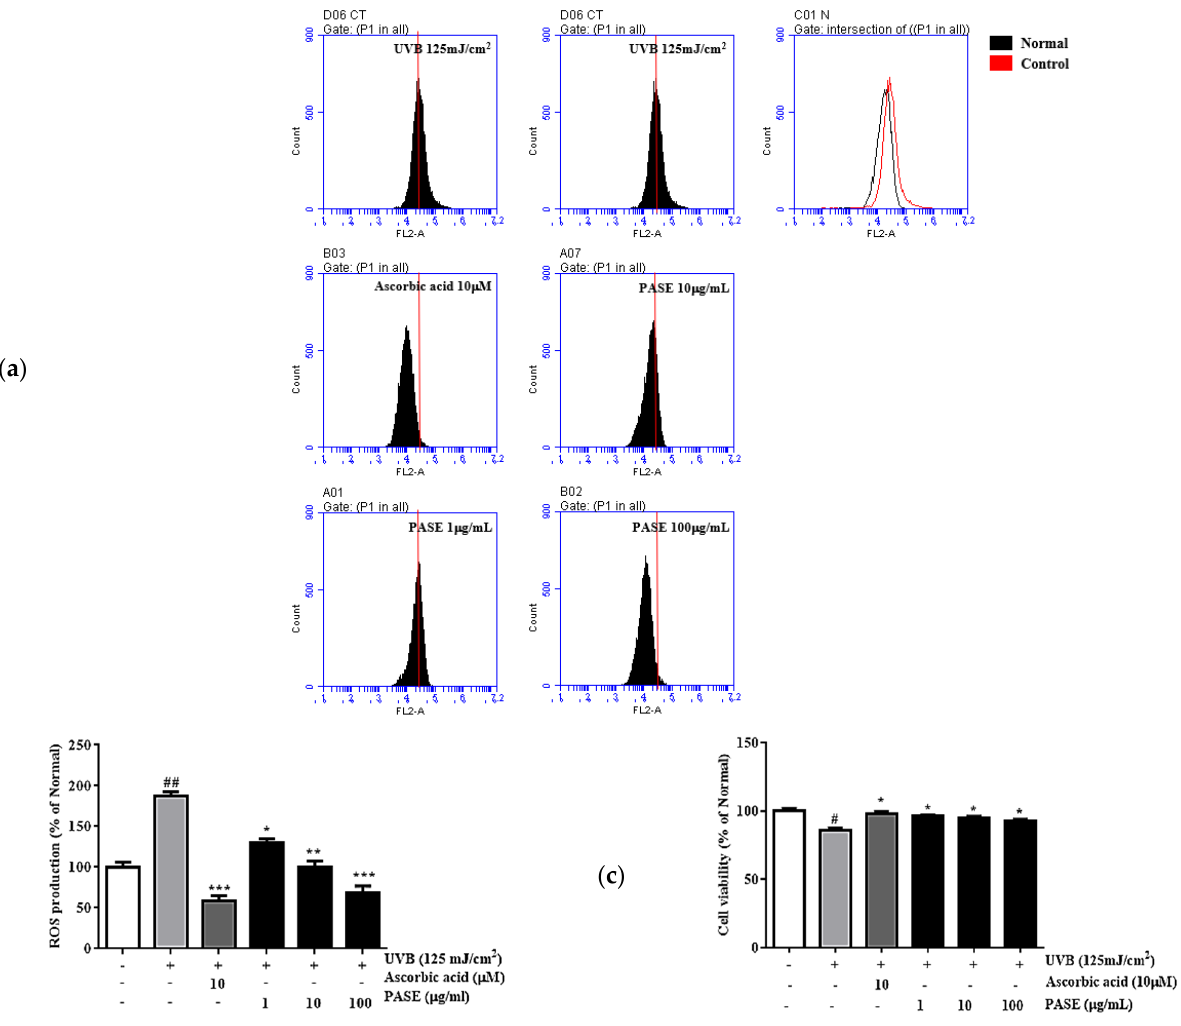
Figure 3. Cell viability and intracellular ROS levels in UVB-exposed HaCaT cells treated with PASE: Intracellular ROS levels are plotted against DCFH-DA levels detected by the FL-2 channel ( a ). The relative intensity is shown in the histogram ( b ). Cell viability was measured using MTT assays ( c ). Data are shown as means ± SDs of three independent experiments. # p < 0.05, ## p < 0.01 compared with non-exposed group, * p < 0.05, ** p < 0.01, *** p < 0.001 compared with only UVB-exposed group.